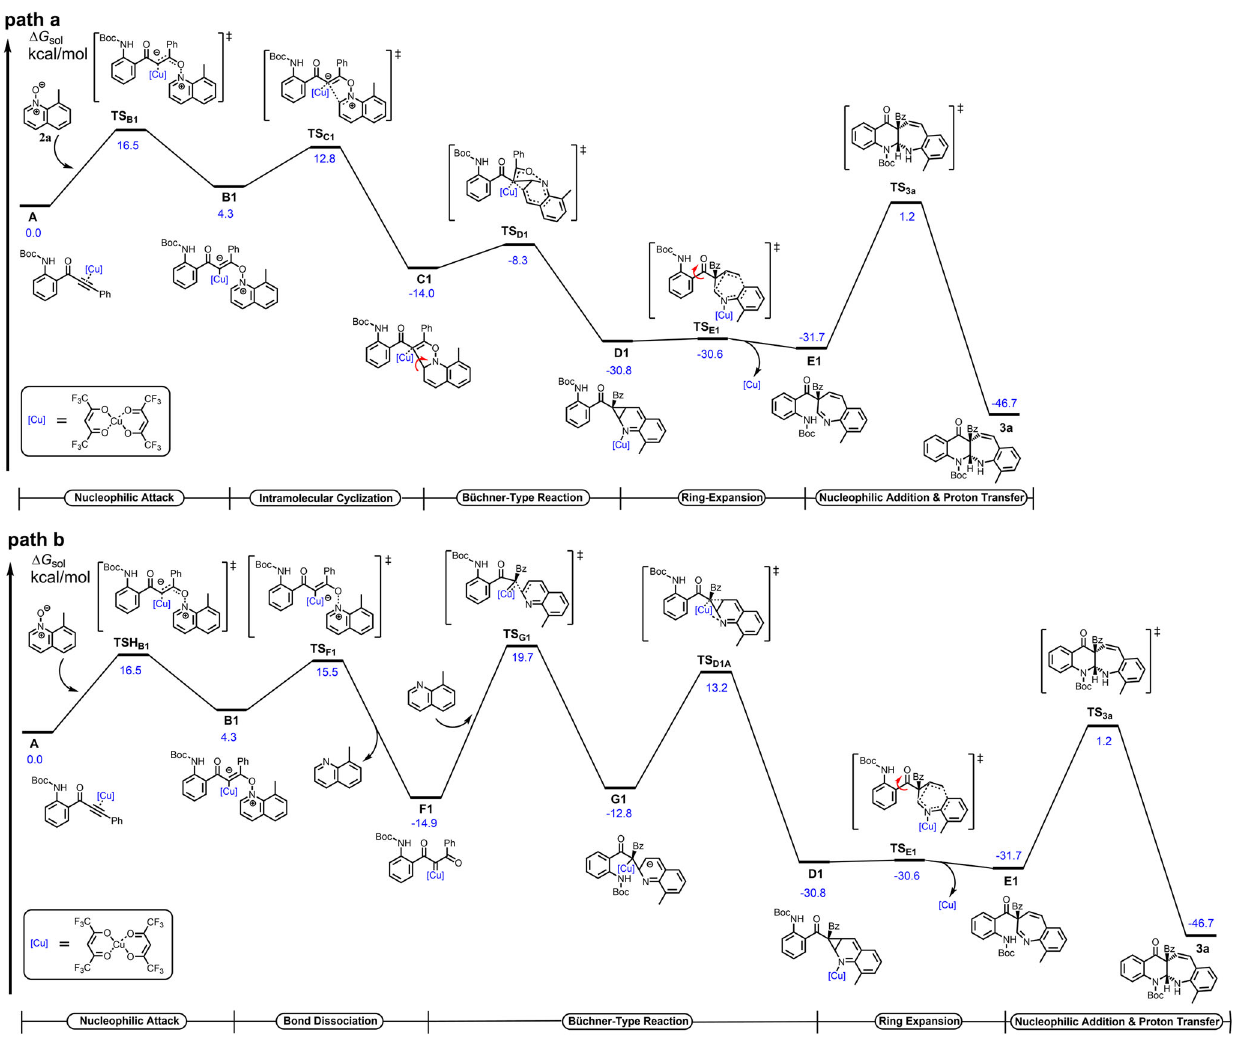
Fig. 8 Plausible reaction mechanism for the formation of 3a. a α -oxo copper carbene intermediate was not involved. b α -oxo copper carbene intermediate was